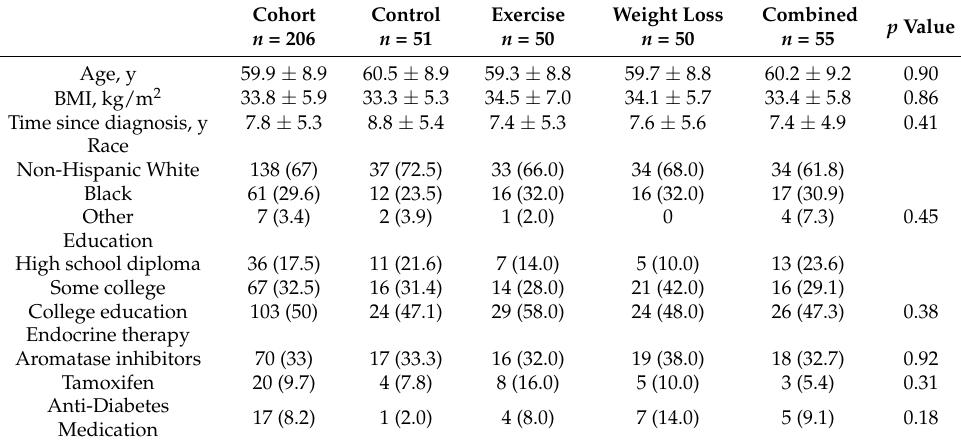
Table 1. Demographic and clinical characteristics of the groups at baseline.